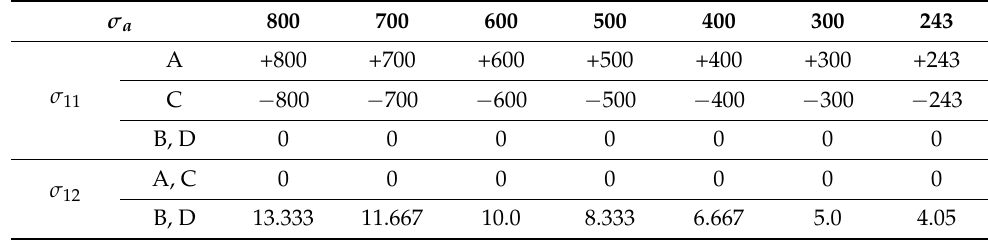
Table 2. Extreme values of normal σ 11 and shear σ 12 stresses at the Points A, B, C, and D caused by cyclic stress amplitude σ a , MPa.